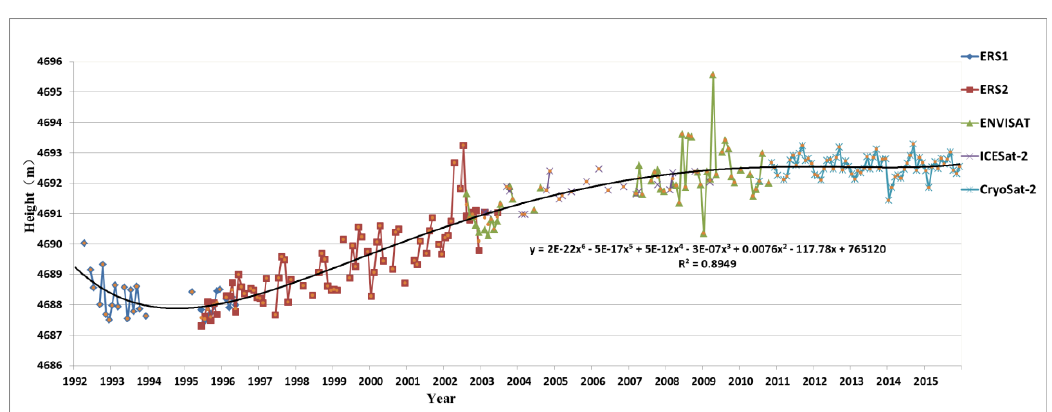
Figure 4. Multi-mission radar altimetry results after eliminating the systematic